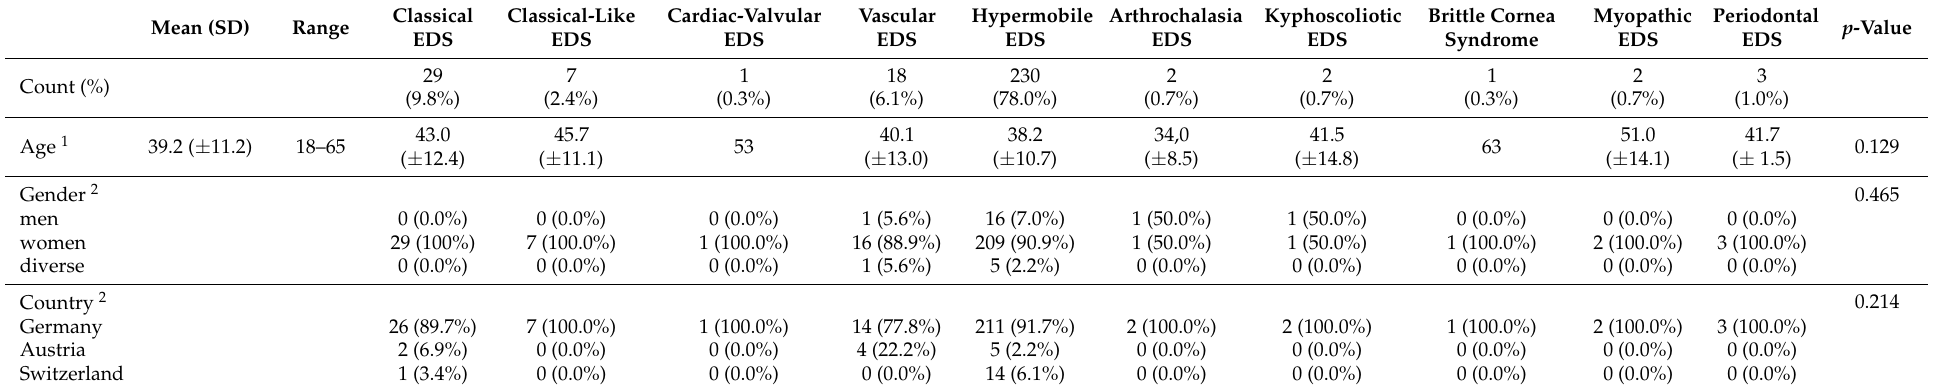
Table 1. Overview of the results from 3.1 to 3.2; p -values for categorical variables were calculated using a Chi-square test, and for continuous variables; a Kruskal-Wallis test was performed to calculate p -values; subtype according to the international classification of 2017 [3]; standard deviation not given for cardiac-vascular EDS and Brittle Cornea Syndrome, only one participant, respectively; 1 = in years; 2 = percentages are given for each subtype.